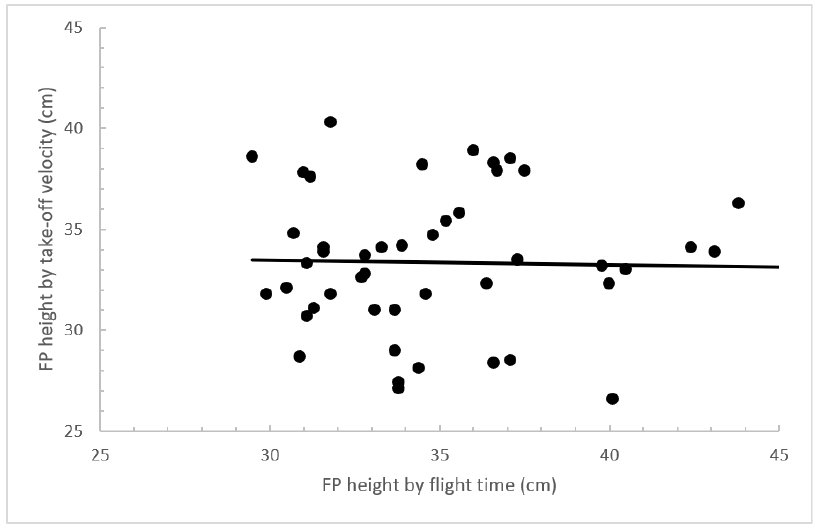
Figure 3. Pearson’s correlation between jump heights measured by the FP using take-off velocity and the FP using flight time; FP, force platform; graph made by the authors.